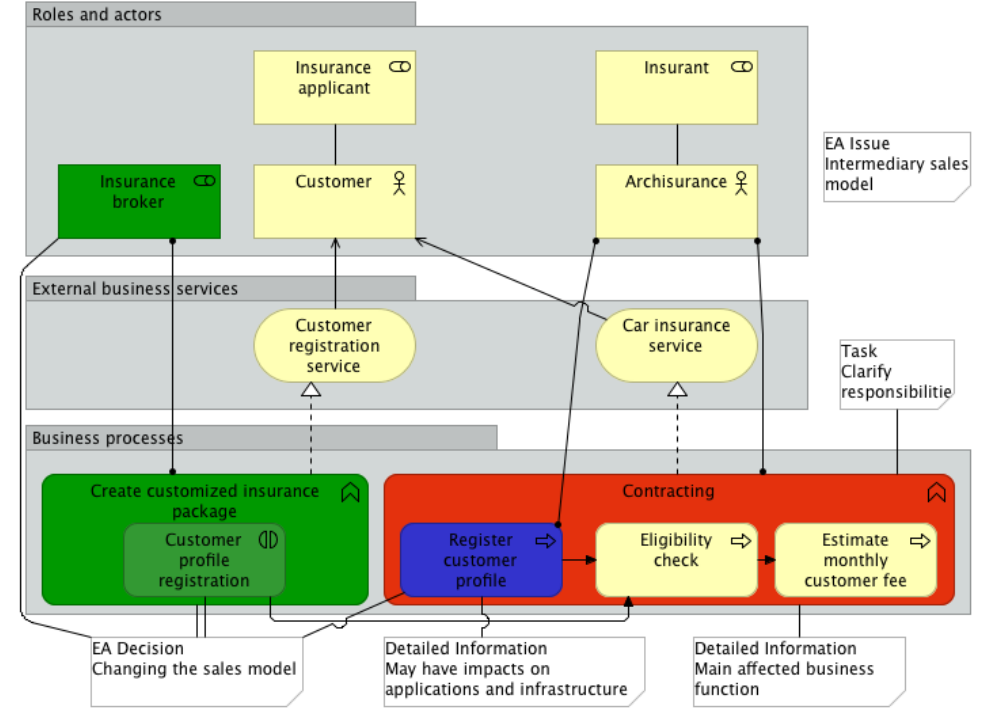
Figure 8. Adapted Business Process Viewpoint